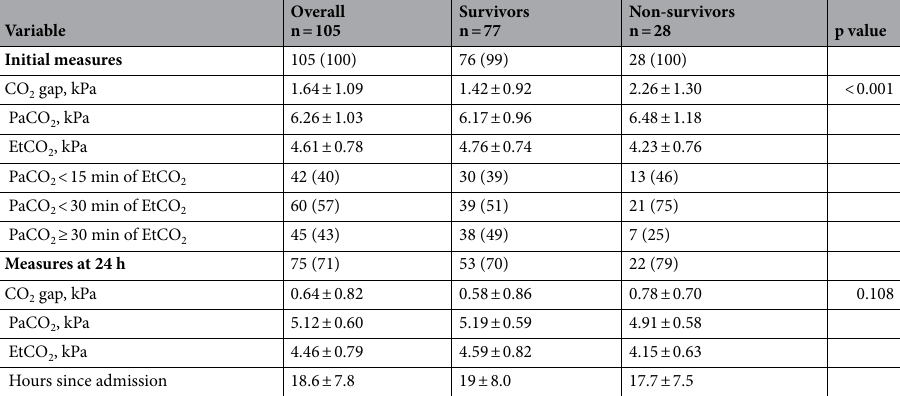
Table 2. PaCO 2 and EtCO 2 pairs at admission and after 24 h. Data was complete. Numbers are presented with percentages of total in parentheses. Continuous variables are reported as mean ± SD (standard deviation). The CO 2 gap and the PaCO 2 variables were skewed; however, the mean ± SD was presented due to the use of these parameters in the Bland–Altman plots. CO 2 gap = PaO 2 —EtCO 2 . For the measures at 24 h there was no time delay measurement of EtCO 2 and PaCO 2